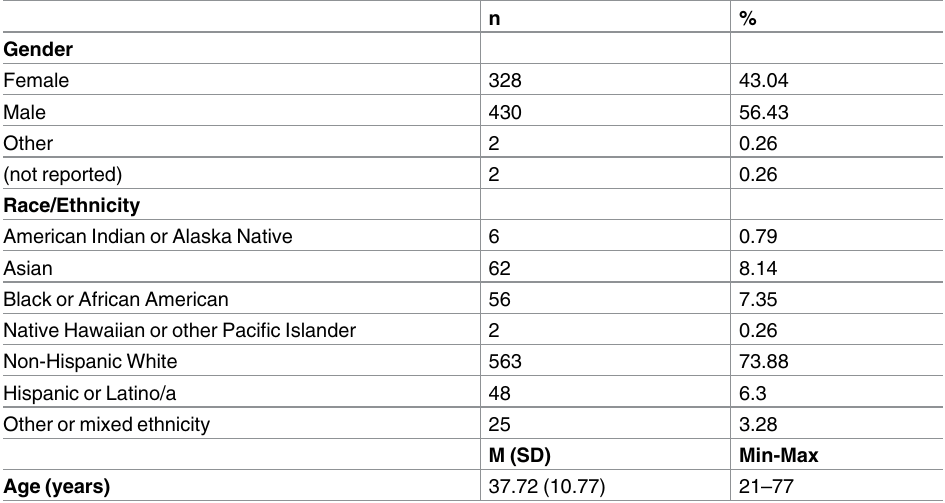
Table 1. Participant